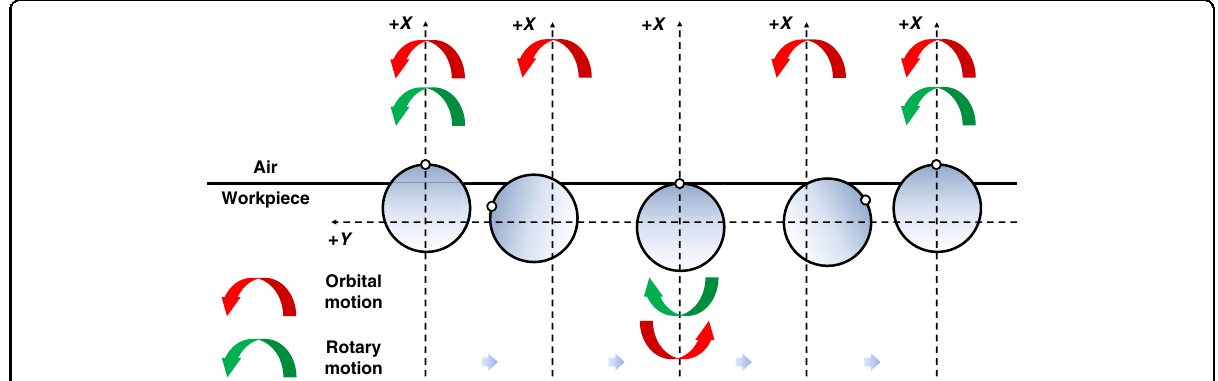
Fig. 6 Schematic diagram of heterocercal motion strategy. Double rotary motion is set to enhance the material removal at edge. Red stands for orbital motion direction, while green for spin motion direction